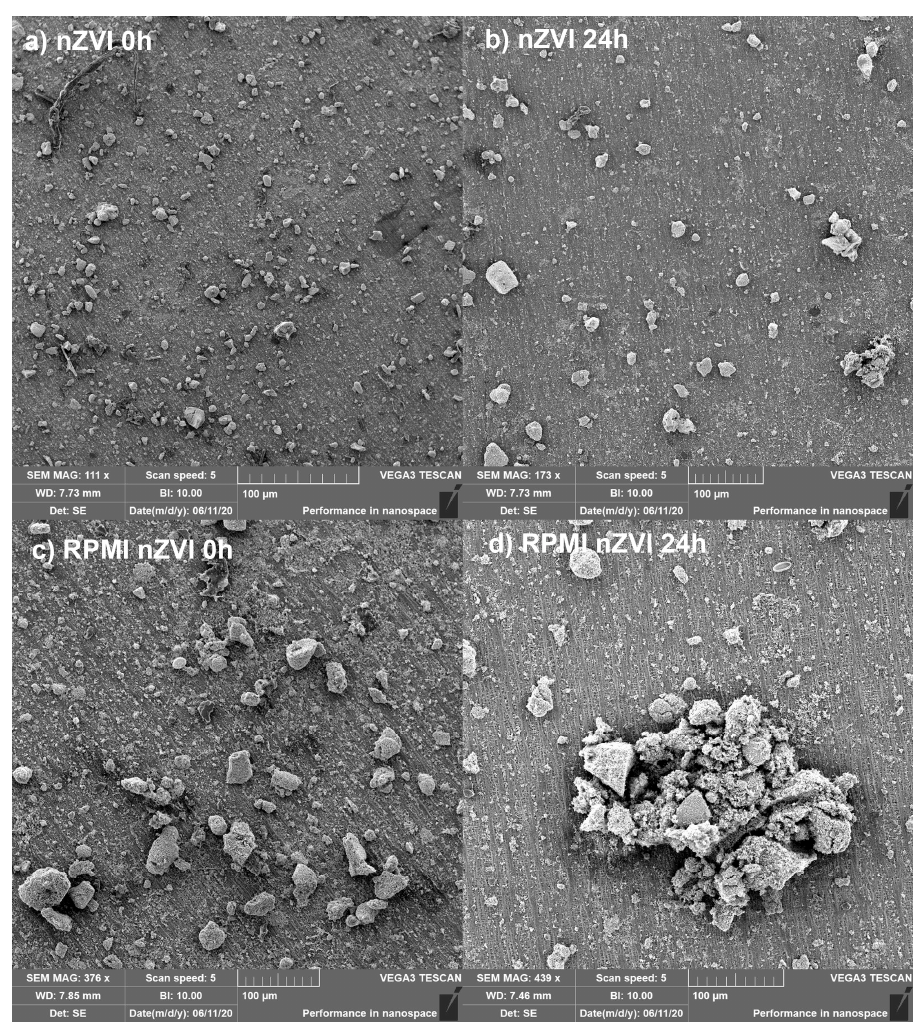
Figure 1. Scanning electron microscopy (SEM) images of fresh and aged nanoscale zero-valent iron (nZVI) in water and in the exposure medium (RPMI 1640): ( a ) Freshly prepared nZVI in distilled water; ( b ) nZVI aged for 24 h in distilled water; ( c ) Freshly prepared nZVI in RPMI 1640 medium; ( d ) nZVI aged for 24 h in RPMI 1640